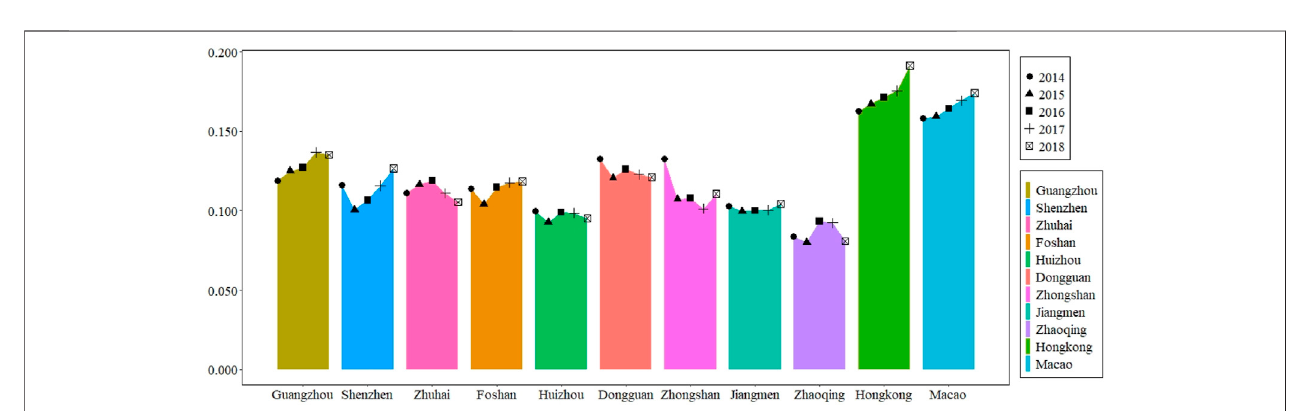
FIGURE 4 | Sustainable development level of the compound ecosystem in the GBA.